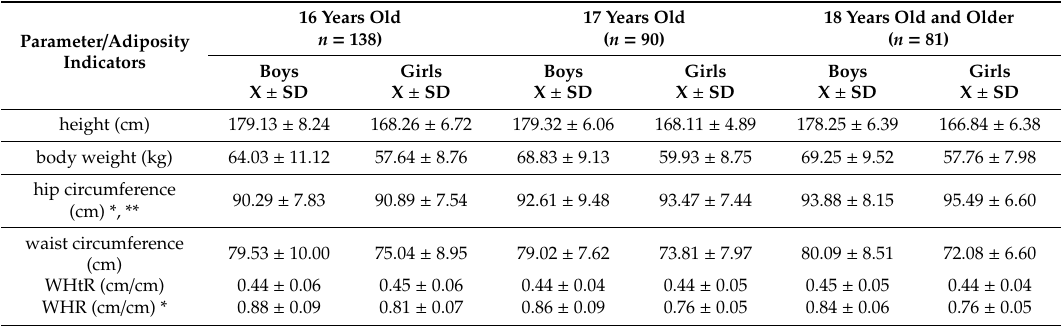
Table 4. The average height, body weight and fatness indexes values with reference to gender in age group of the examined